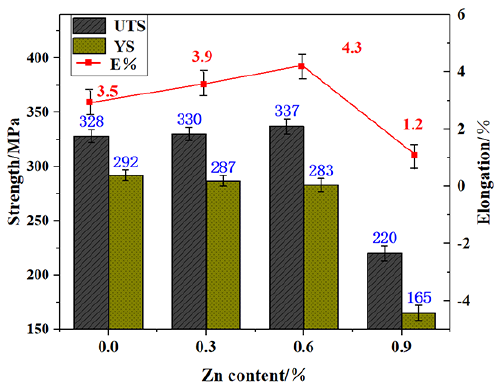
Figure 6. E ff ect of Zn content on the mechanical properties of Al–9Si–1.2Cu–0.4Mg-based alloys during Figure 6. Effect of Zn content on the mechanical properties of Al – 9Si – 1.2Cu – 0.4Mg-based alloys the heat treatment. during the heat treatment.